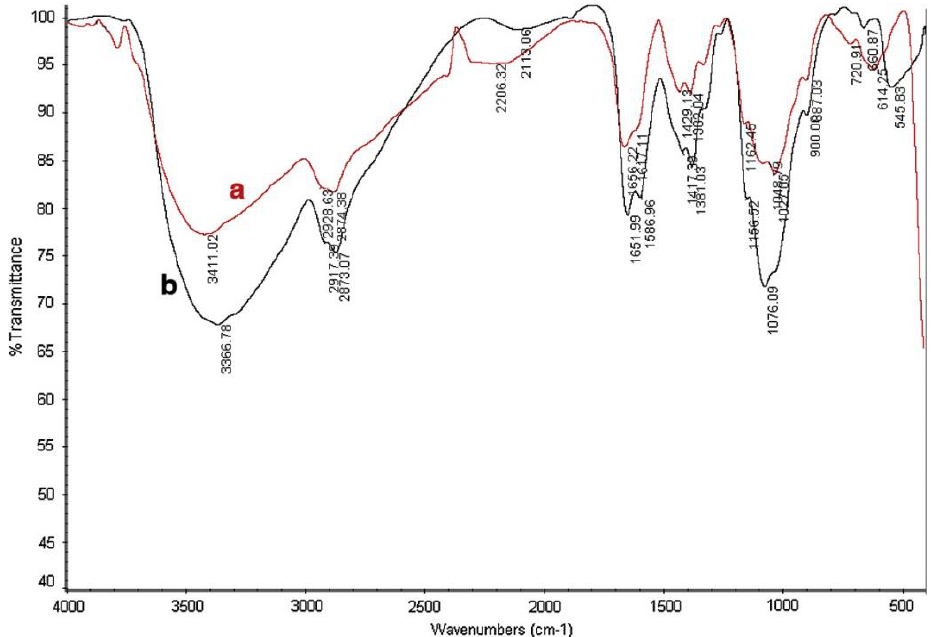
Figure 16. FT-IR spectra for ( a ) pure chitosan and ( b ) CS-ZnO NPs composite. Reprinted with permission from Ref. [175]. Copyright 2014 Elsevier.